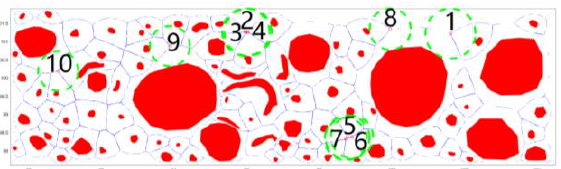
Figure 3. Final result on hazard and safe landing site selection In the stage of safe landing site selection, via the method described in section 2.3, we subdivide the whole area as the blue lines in Figure 3 shows. Then, by searching all points intersected of 3 blue lines, we select 10 candidate sites according to the distance to its nearest obstacle. Each of these 10 selected candidate sites is surrounded by a circle with green color, respectively. Next we calculate the performance index for each site using the method mentioned in section 2.3. By accumulating the sub-index scores listed in Table 1, we know that the final recommend landing spot is located at site 5, its total score is 0.983, the lowest value.